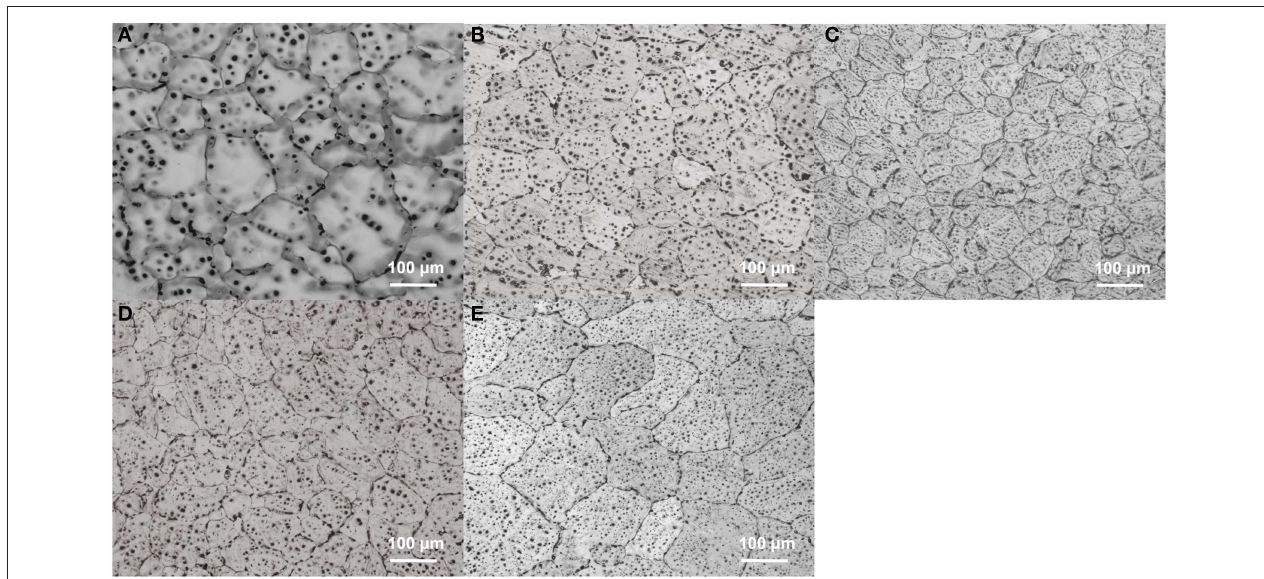
FIGURE 2 | Optical images of as-cast MZC (A) , MZC0.3Mn (B) , MZC0.5Mn (C) , MZC0.7Mn (D) , and MZC0.9Mn (E) alloys.